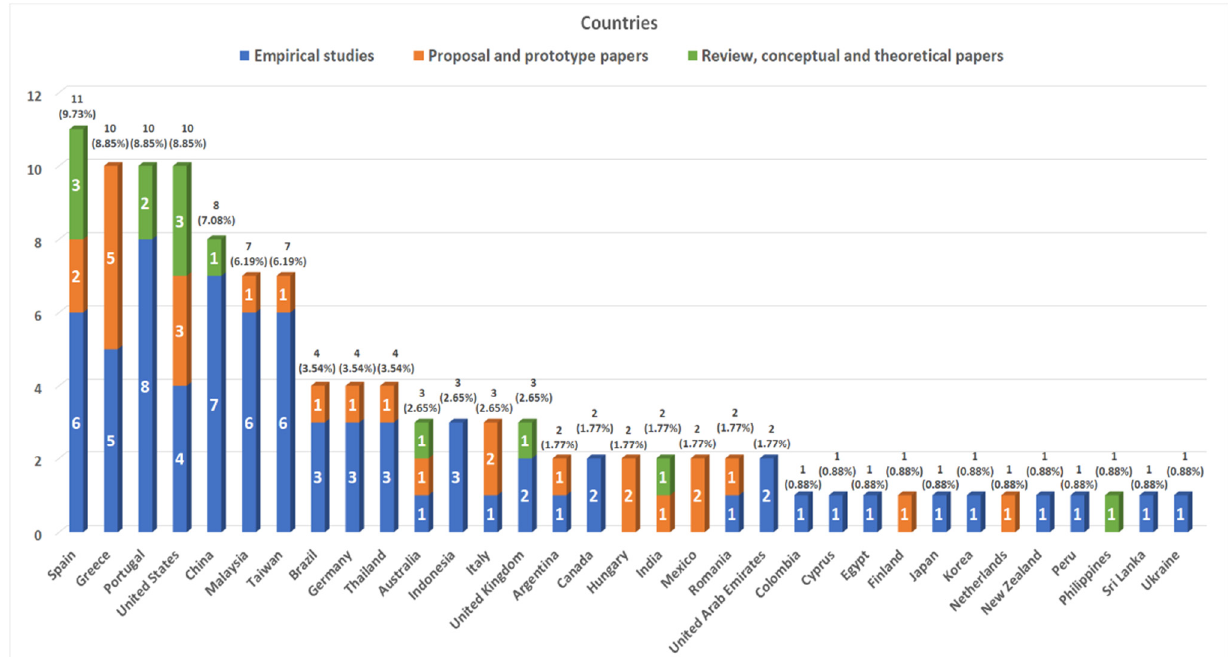
Figure 2. Countries in which the experiments/studies were carried out.